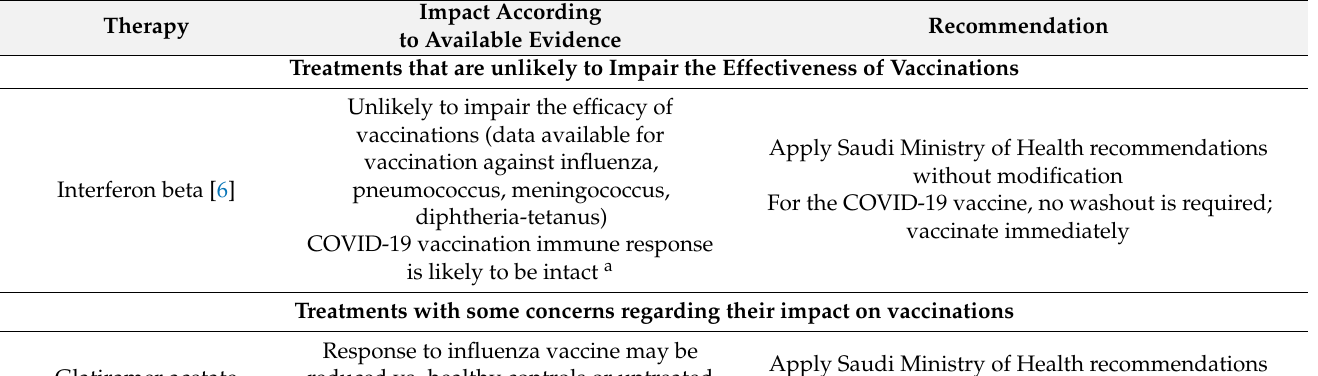
Table 3. Recommendations relating to vaccination of patients receiving specific disease-modifying therapies (DMT) for multiple